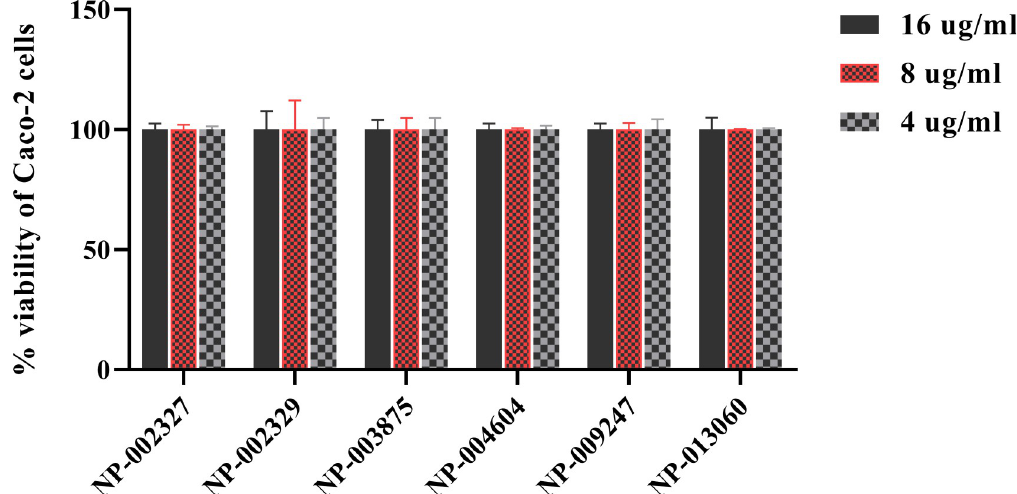
Fig 4. Cytotoxicity assay of natural products against Caco-2 cell line. The percentage of viable Caco-2 cells was measured as the ratio of average absorbance of each sample relative to the negative control (DMSO). The absorbance values represent the mean of three samples of each natural product compound with error bars representing standard deviation values for the